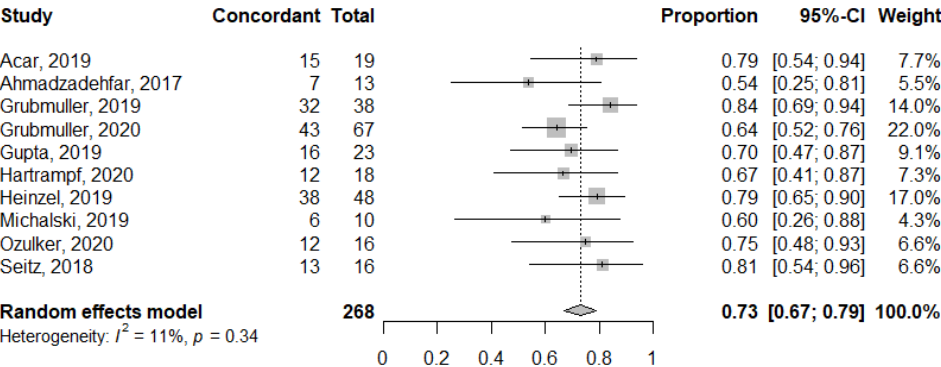
Figure 4. Forest plot of the concordant proportion (concordant/total number of patients) between PSA and PSMA PET response assessments.